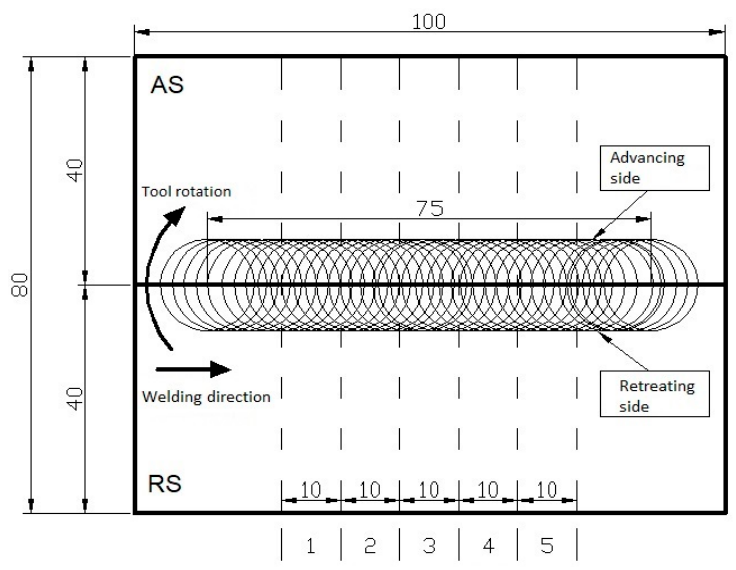
Figure 3. Typical test specimens (all dimensions in mm).